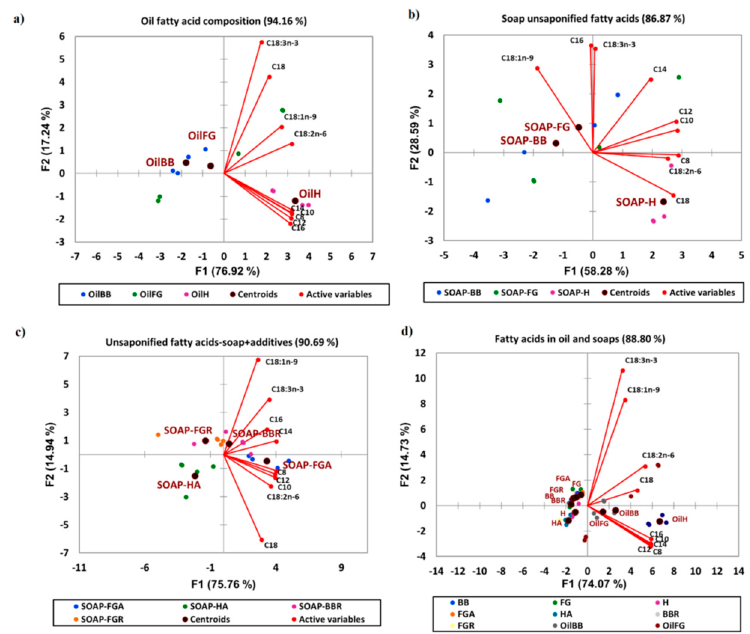
Figure 2. Principal component analysis (PCA) showing the similarities between different commercial soaps based on the fatty acids composition. Biplots showing clusters of ( a ) the oils used to make the natural soaps based on the fatty acid composition, ( b ) the three natural soaps made after cold saponification based on content of unsaponified fatty acids, ( c ) three natural soaps after additives were added based on unsaponified fatty acid composition, ( d ) oils and soaps with and without additives based on the fatty acid composition in oils (feedstock) and unsaponified fatty acids in soaps; n = 4 per experimental replicate. Unsaponified fatty acids are arranged based on the fatty acid composition with the number before the colon representing total number of carbons, while the numbers after the colon represents the total number and position of first double bonds (e.g., C16:3n3 = 16 carbons with 3 double bonds; first double located at carbon 3 counting from the terminal end. Natural soap acronyms: BB = base bar (control), FG = forest grove, H = Hibiscus rose hip. FGA = forest grove + essential oil and clay, HA = hibiscus + essential oil and clay, BBR = base bar + rosemary, FGR = Forest grove + rosemary, HR = hibiscus + rosemary. Table 2. The effects of cold saponification and natural additives on the unsaponified fatty acid composition in different commercial natural soaps. Soaps without Additives Soaps + Natural Additives Fatty Acids